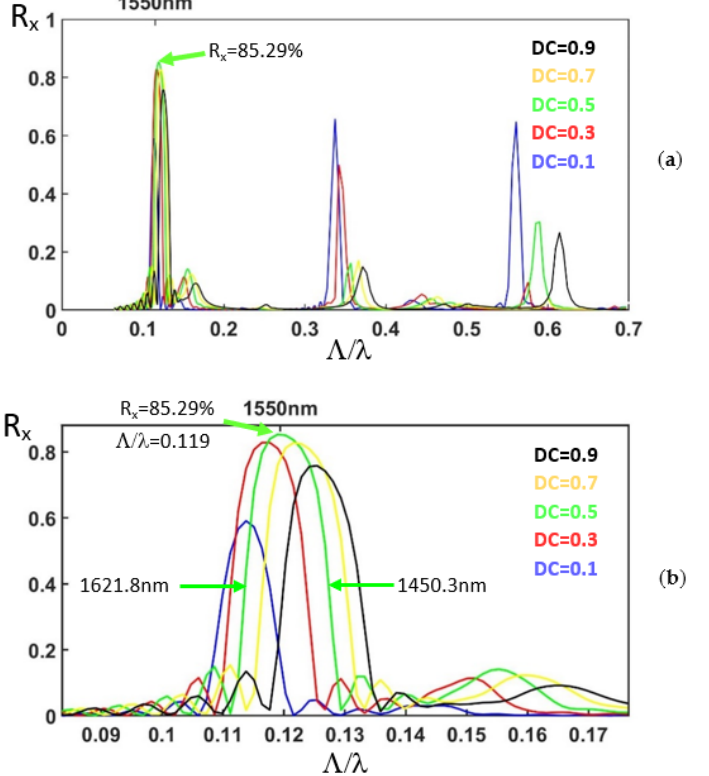
Figure 2. Reflection spectra for the TE mode (E X ) as the light of the TM mode (E Y ) is launched. The number of periods is 30. The horizontal axis is the normalized frequency ( a ) from 0 to 0.7 ( b ) from 0.08 to 0.175.